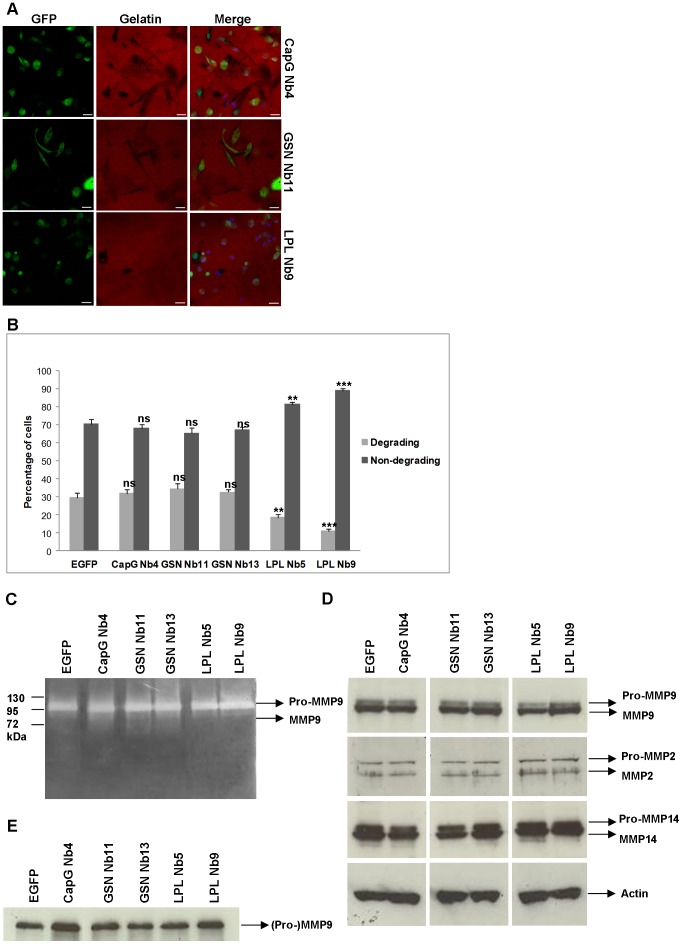
LPL Nbs impair gelatin degradation by THP-1 cells but MMP production and secretion remain unaffected.THP-1 cells were plated onto Cy3-labeled gelatin-coated glass coverslips for 24 hours and subjected to immunofluorescence analysis. (A) EGFP-tagged nanobodies are depicted in green and gelatin in red. In the merged pictures, the nuclei are stained by DAPI and depicted in blue. Dark regions in the fluorescent gelatin monolayer (red) are indicative of gelatin degradation. Bar: 30 µm. (B) Quantification of the percentage of THP-1 cells capable of degrading the gelatin matrix. Data indicate means +/− SEM from 3 independent experiments (n = 450–800). Unpaired t-tests were performed to observe statistical differences in the degradation potential between cells expressing EGFP and cells expressing the nanobodies (ns: non significant p>0.05; ** p<0.01; *** p<0.001). Stably transduced THP-1 cells (5×105 cells per condition) were seeded into 12-wells in the presence of PMA for 72 h. (C) The conditioned media of these cells were subjected to gelatin zymography. (D, E) Immunoblot analysis performed on THP-1 cell lysates (D) and conditioned media (E) for (pro-)MMP2, (pro-)MMP9,(pro-)MMP14 (D) and (pro-)MMP9 respectively (E). In (D), actin was used as a loading control. These data are representative of 8 independent experiments.